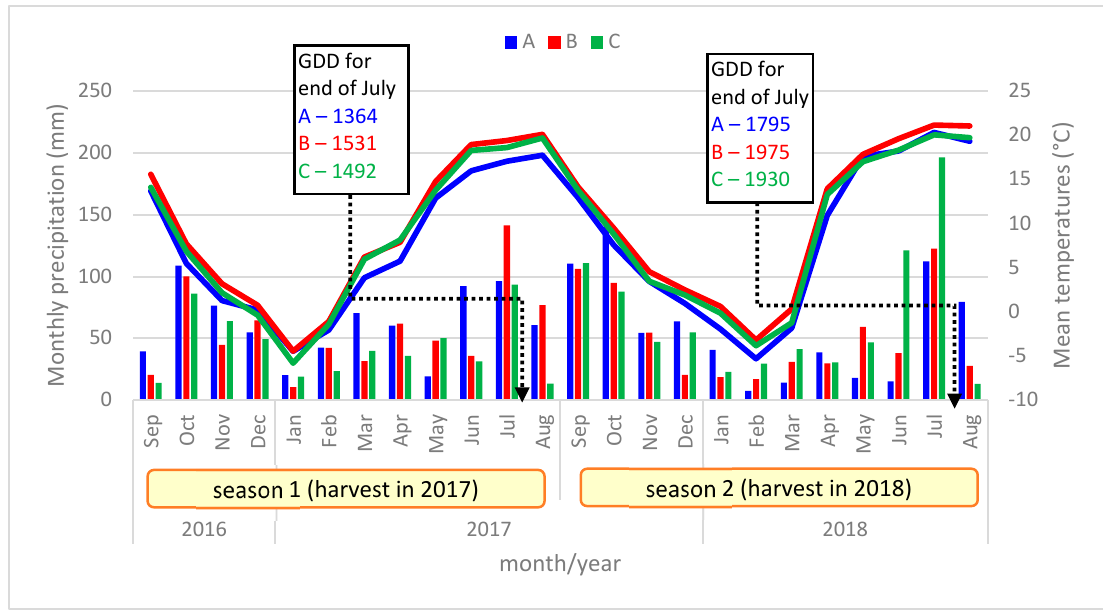
Figure 2. Monthly sums of precipitation, mean air temperature and growing degree days (GDD) for meteorological stations located closest to the research sites (for location A—Olecko, for location B— Pu ł awy, for location C—Strzy ż ów) from the IMGW ‐ PIB national institute (source of data: https://danepubliczne.imgw.pl/).